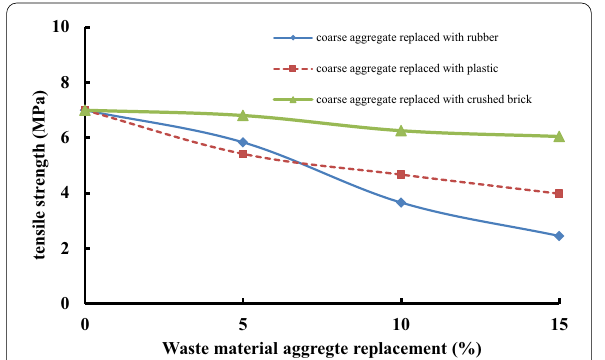
Fig. 9 Elastic modulus of concrete with different types of waste